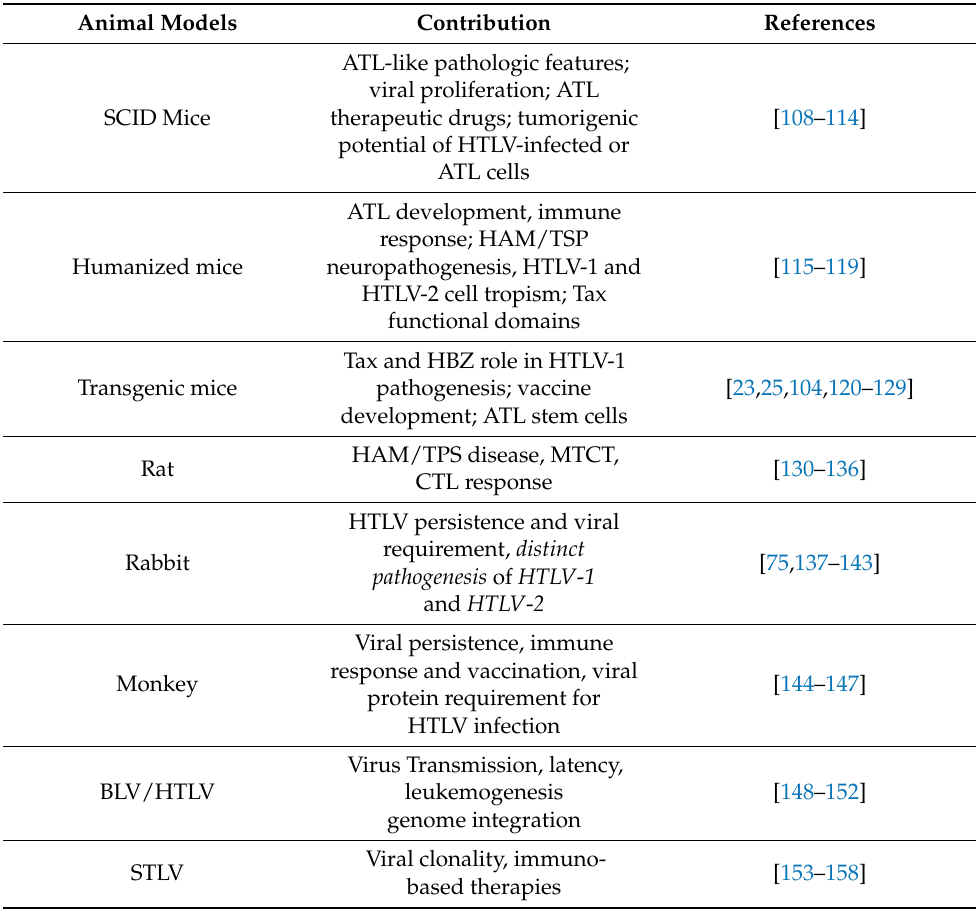
Table 2. Exemplification of animal models contribution for HTLV